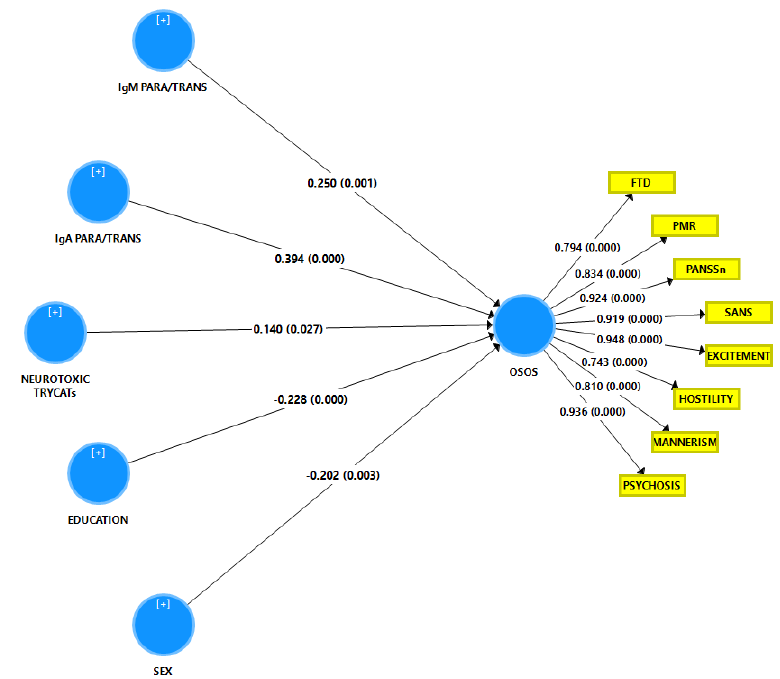
Figure 3 . Results of Partial Least Squares (PLS) analysis. This analysis is performed in the total study group with a latent vector extracted from the eight symptom domains as an output variable (named: overall severity of schizophrenia or OSOS) and the biomarkers, sex and education as input variables. SANS: Scale for the Assessment of Negative Symptoms; PANSS: the Positive and Negative Syndrome Scale; FTD: formal thought disorders; PMR: psychomotor retardation (see table 1 for computation). IgA/IgM PARA/TRANS: IgA/IgM directed to paracellular / transcellular proteins; Neurotoxic TRYCATs (tryptophan catabolites): IgA PA+XA+3HK computed as IgA directed to the sum of the z scores of picolinic acid, xanthurenic acid and 3-OH-kynurenine. Shown are the path coefficients for the inner model and factor loadings for the outer model obtained by 5000 bootstrap